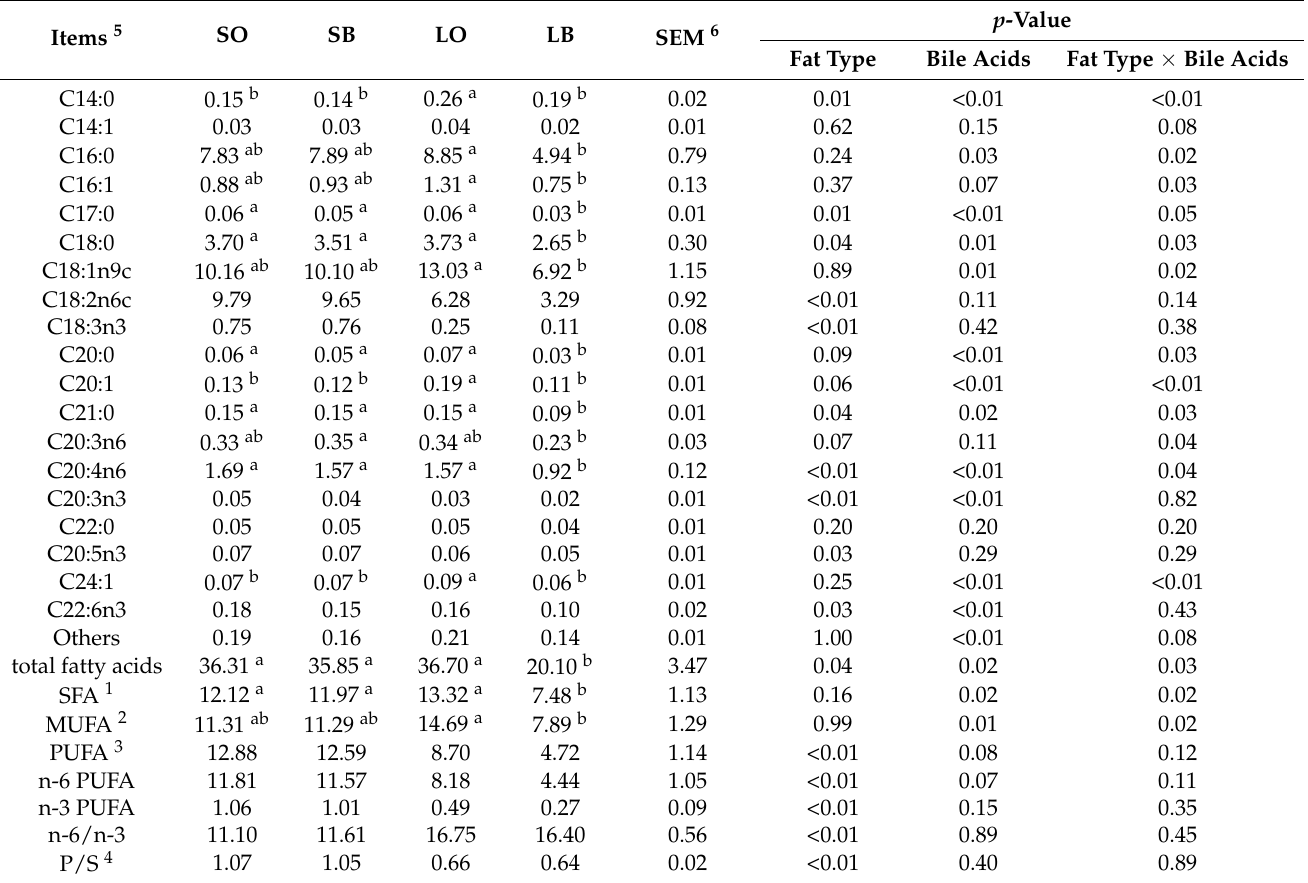
Table 7. Effects of bile acids supplemented in diet included with different types of fat on breast muscle fatty acids composition in broiler chickens